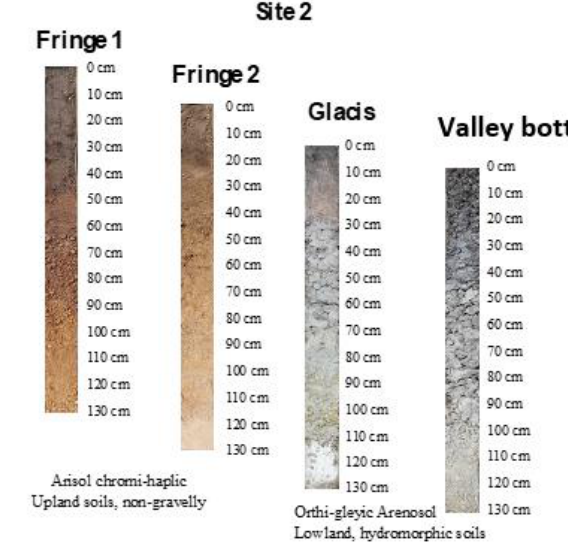
Figure 3. Profiles of the soils at the experimental